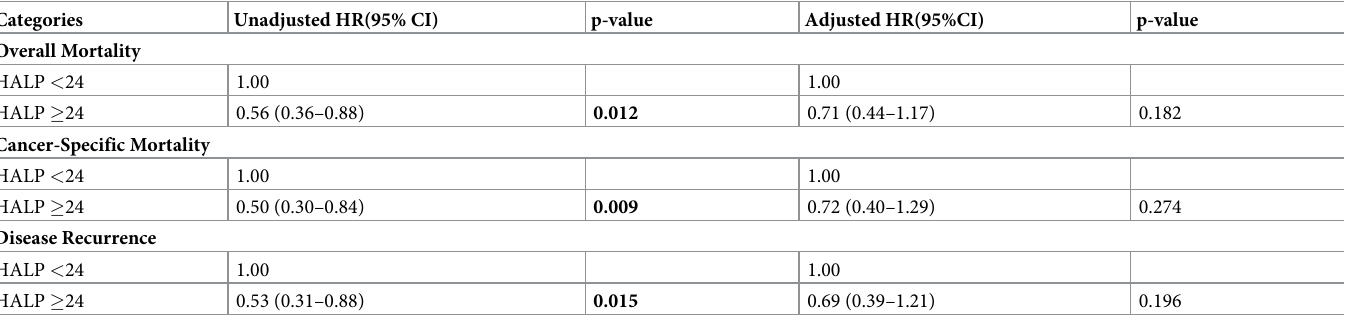
Table 4. Cox regression analysis of haemoglobin, albumin, lymphocyte and platelet (HALP) score categories and endometrial cancer survival outcomes with crude and adjusted hazard ratios and 95% confidence intervals.